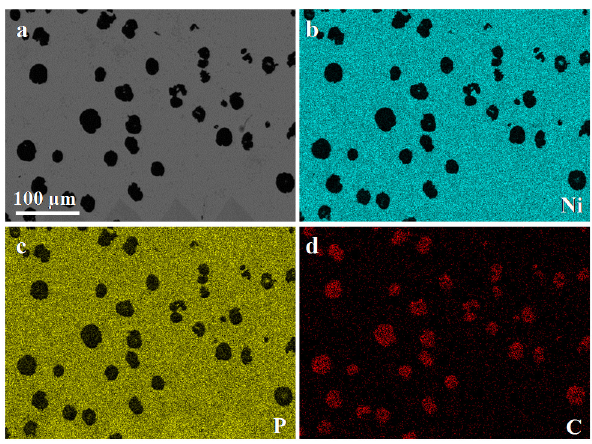
Figure 5. Ni ‐ P coating obtained on the SG cast iron after 5 min at T = 84 °C. ( a ) SEM top ‐ view observation (BSE detector); ( b ) nickel EDX mapping analysis (K α = 7.47 eV); ( c ) phosphorus EDX mapping analysis (K α = 2.01 eV); and ( d ) carbon EDX mapping analysis (K α = 0.27 eV).